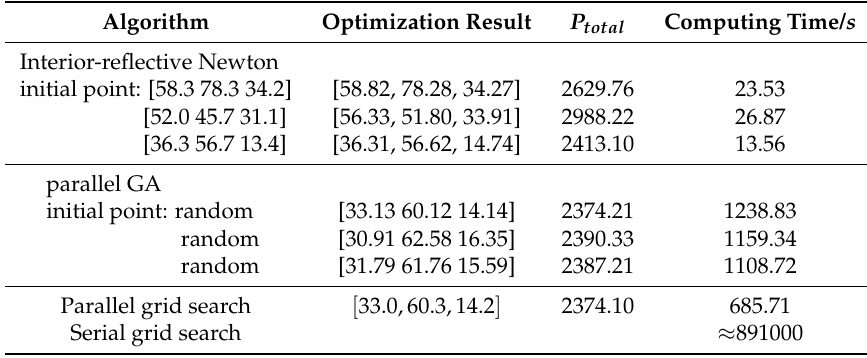
Table 4. Comparison of optimization algorithms.